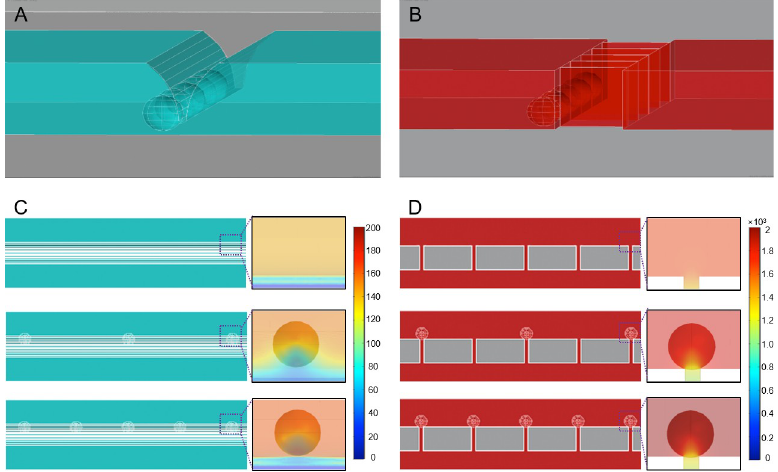
Fig 4. Simulation of two different separation models, with a side and top view, including 5 CTCs with 25 μ m diameter. ( A ) The green model has a slit with a 8 μ m height, a 5 μ m width and 27.9 mm length. ( B ) The red model has a filter consisting of an 8 μ m gap, a 50 μ m height at 100 μ m distance from each other. The filter itself is 27.9 mm long. ( C ) Top view of the green slit-filter model showing the positions of the 0, 3 and 5 CTCs. The pressure profiles around the CTC are exhibited. The pressure ranges from 140, 152 to 161 Pa for 0, 3 and 5 cells, respectively. ( D ) Top view of the red filter model showing the positions of the 0, 3 and 5 CTCs. The pressure distributions on the CTC surfaces are shown. The pressure range from 1652, 1820 and 1955 Pa for 0, 3 and 5 cells,